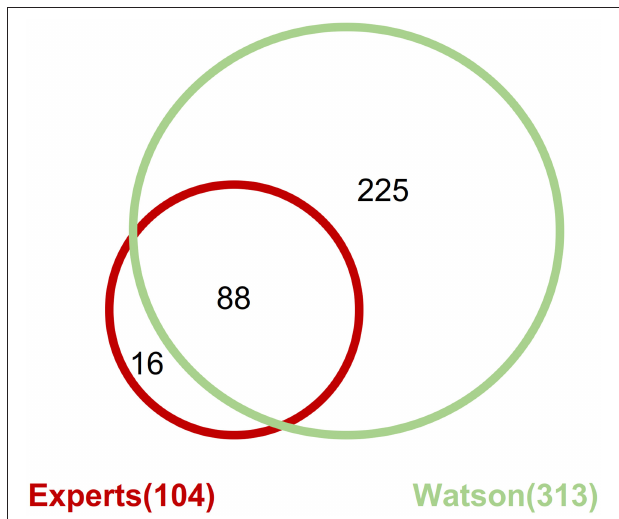
FIGURE 7 | Concordance of proposed targeted drugs between the experts and Watson System against gene alterations determined as pathogenic by both method including 206 mutations, 39 amplifications, and 4